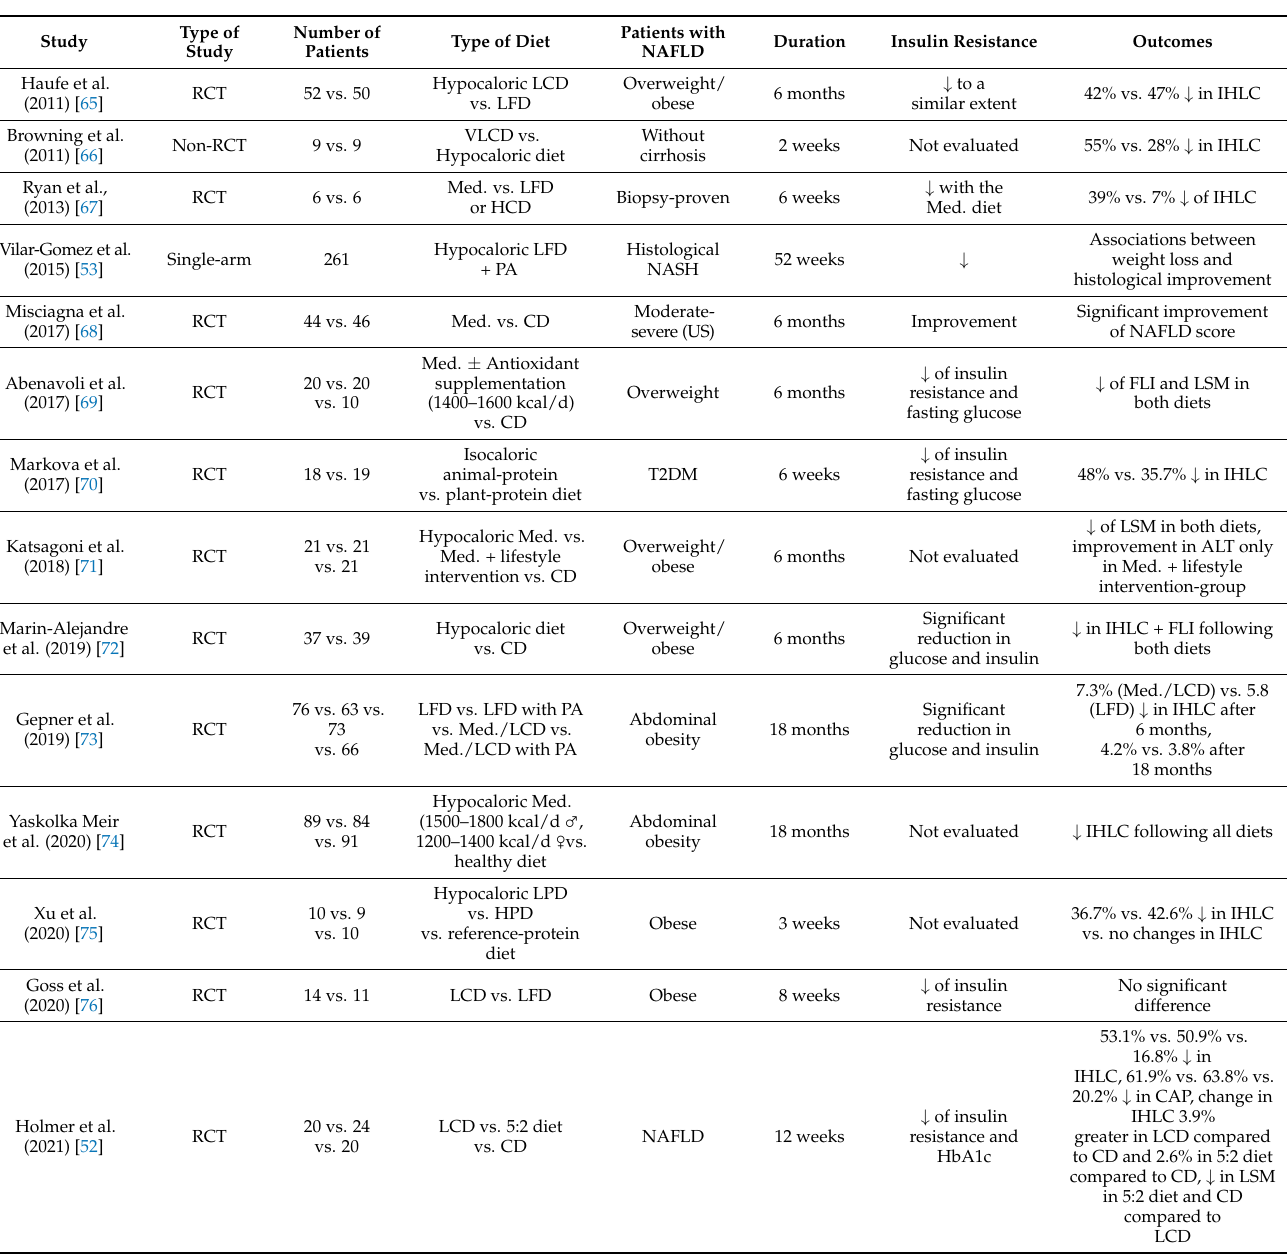
Table 2. Dietary interventions and outcomes in NAFLD